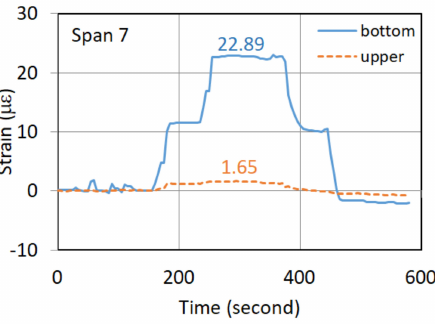
Figure 4. Strain response of the seventh northward span under the static test.